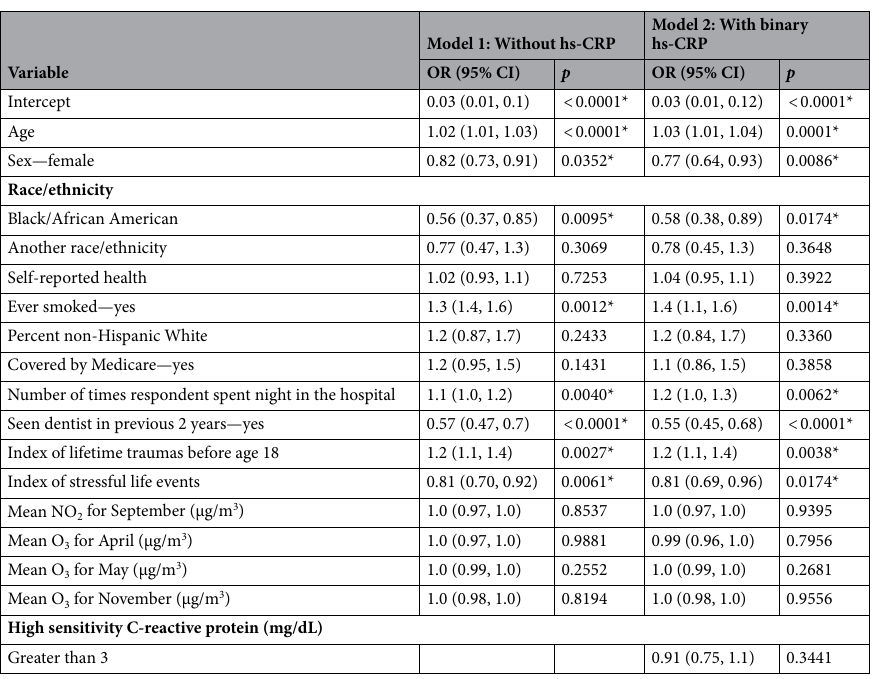
Model 1: Without